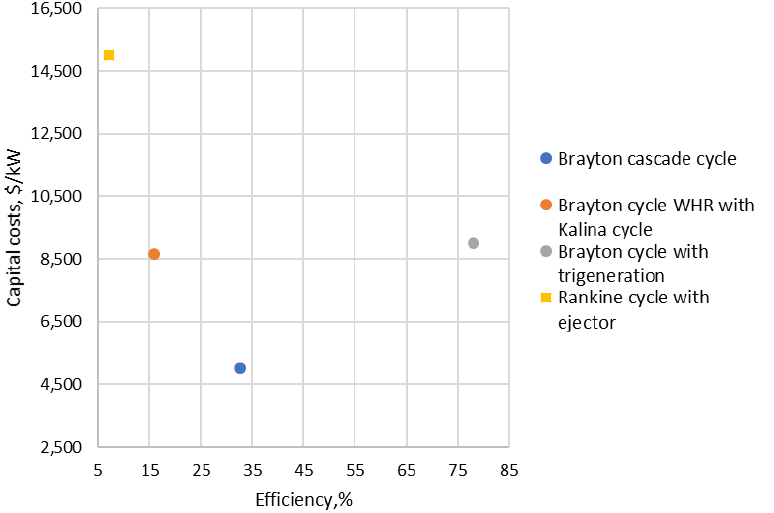
Figure 30. Technologies for carbon dioxide microgeneration cycles.